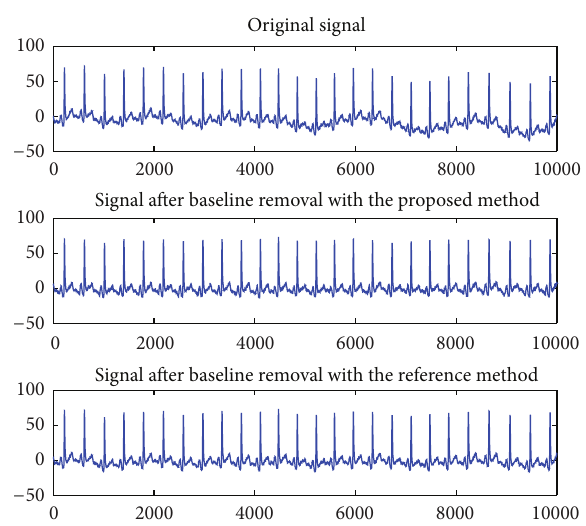
Figure 9: Comparison between the proposed method and the reference